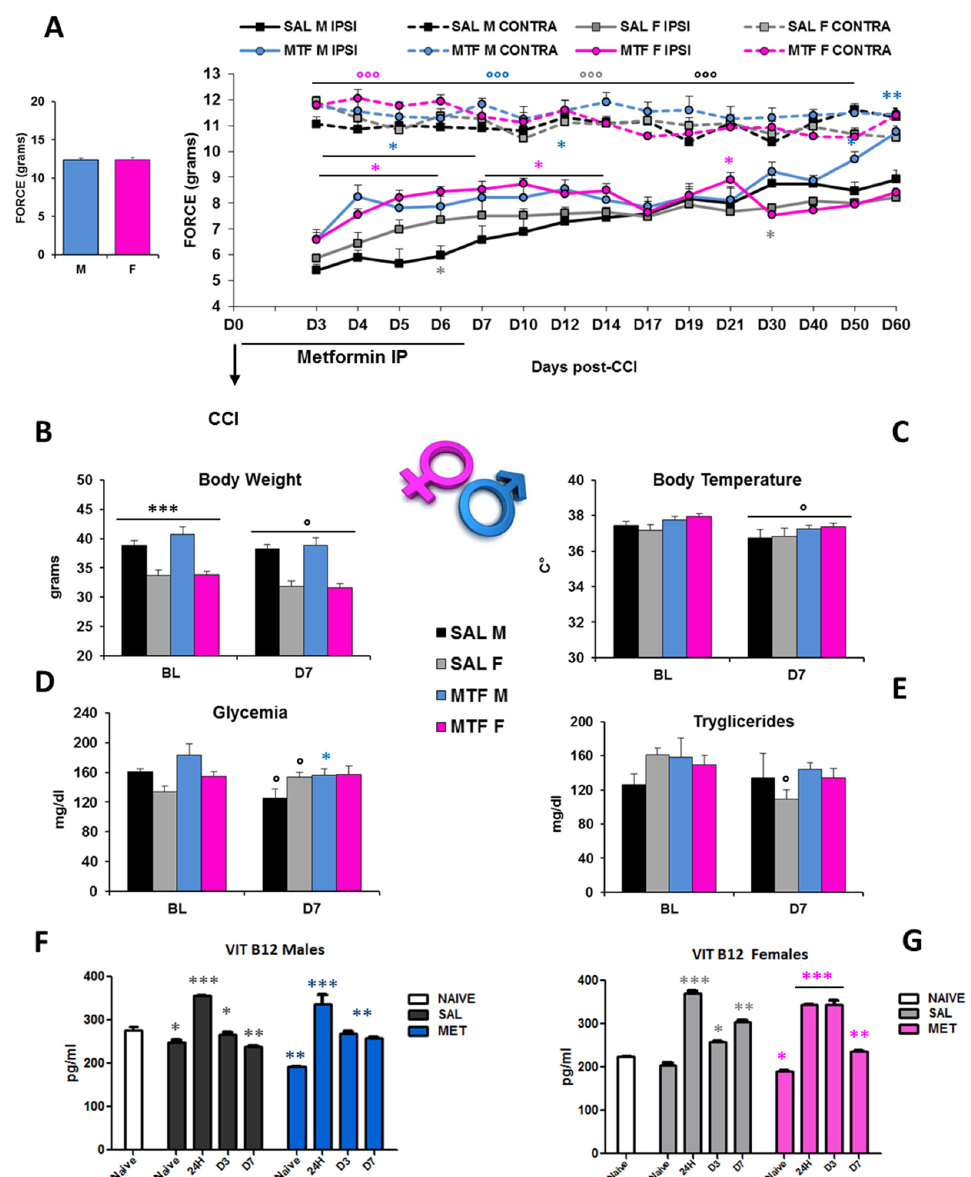
Figure 1. Sex-dependent anti-allodynic effects of MTF administration and metabolic changes. ( A ) left graph: threshold of response (force in g) to non-noxious stimuli (dynamic plantar aesthesiometer